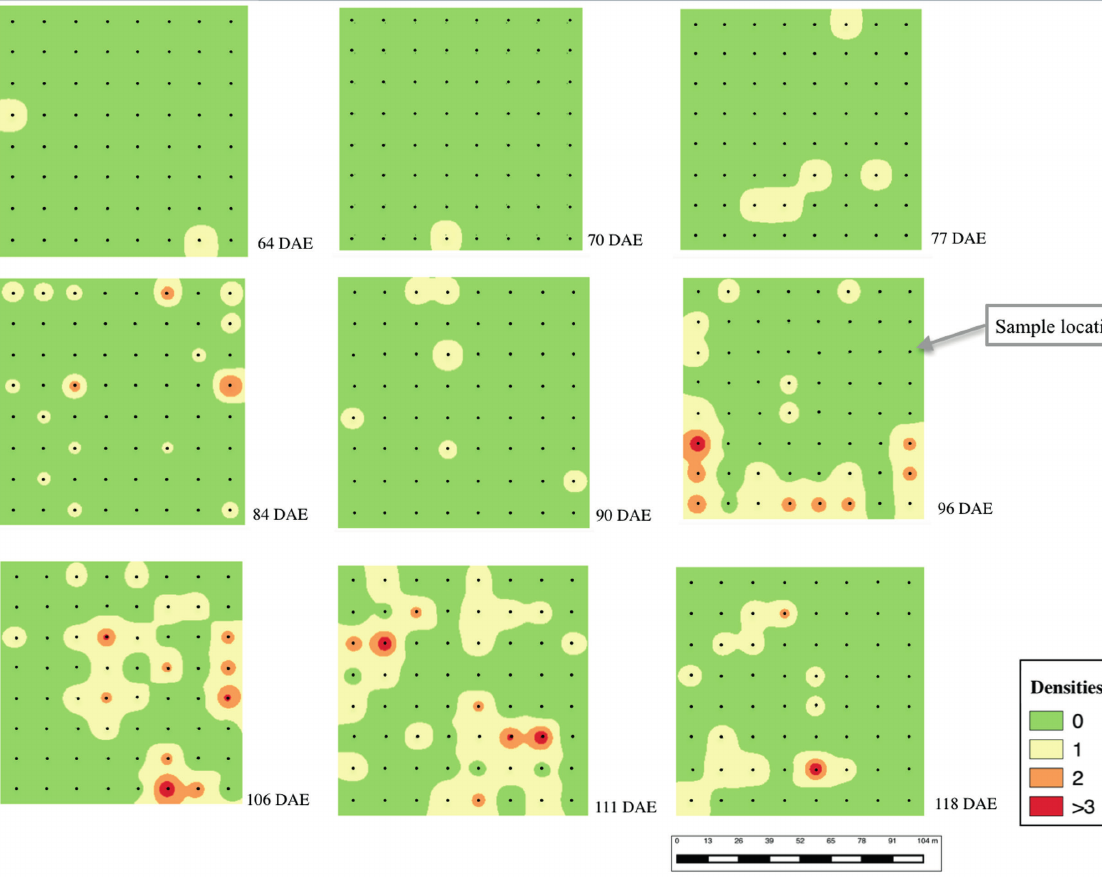
Figure 2 - Surface maps constructed based on Inverse Distance (IDW) interpolation showing spatial distribution of stink bug density in cotton in nine sampling dates between 64 and 118 days after emergence (DAE). Low density is represented in green while red indicates high density of E. heros